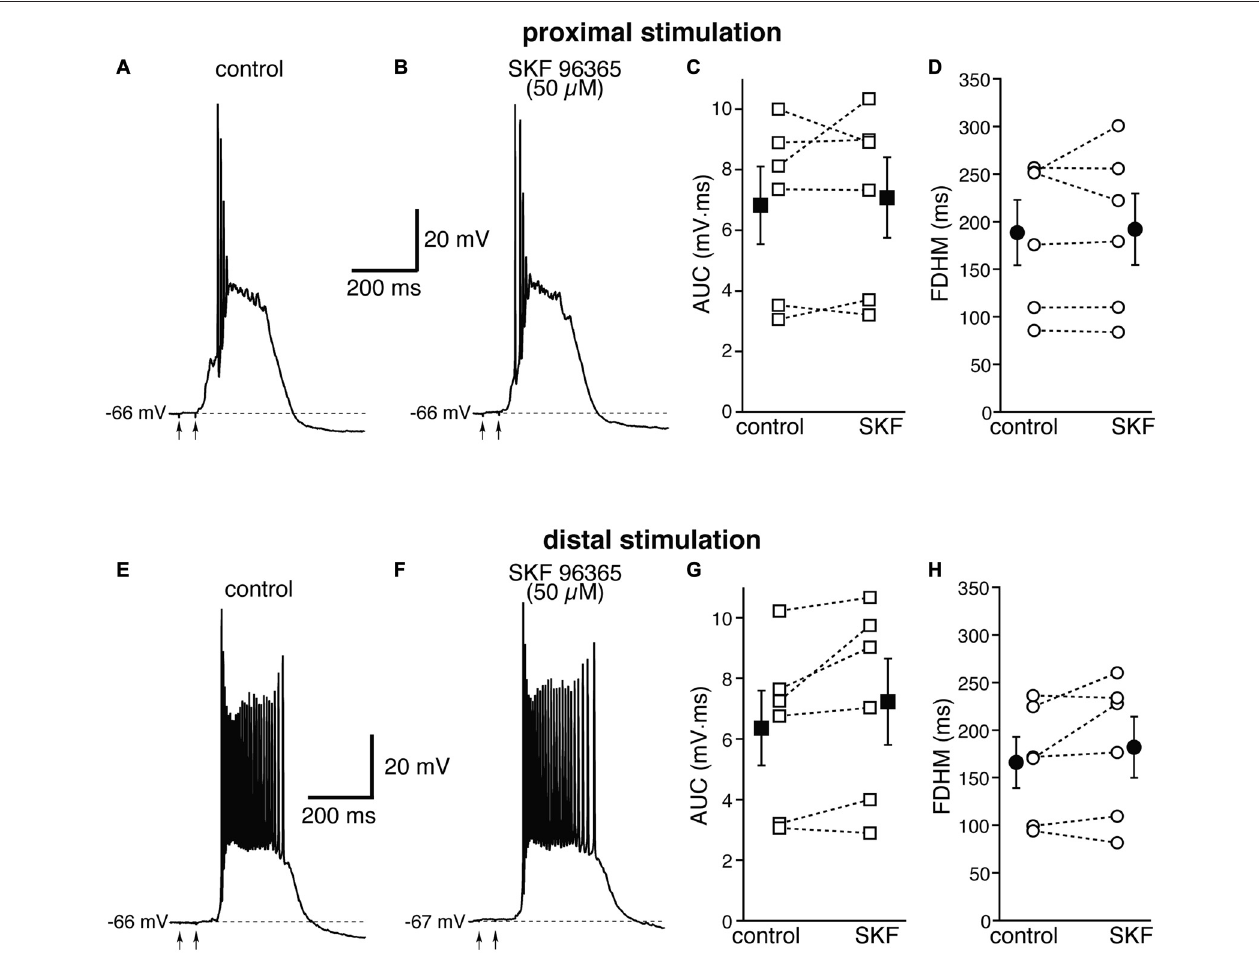
FIGURE 8 | The transient receptor potential canonical (TRPC) channel blocker SKF 96365 does not affect the bursts in EC layer V neurons, at either proximal or distal locations. Top, representative trace of a burst recorded upon stimulation of proximal afferent fibers in control conditions (A) and in the presence of SKF 96365 (50 µ M, B ). SKF 96365 did not significantly affect either the AUC (C) , or the FDHM (D) in n = 6 neurons. Bottom, representative trace of a burst recorded upon stimulation of distal afferent fibers in control conditions (E) and in the presence of SKF 96365 (F) . SKF 96365 did not significantly affect either the AUC (G) , or the FDHM (H) in n = 6 neurons. The traces in (A,B) and (E,F) were recorded from different